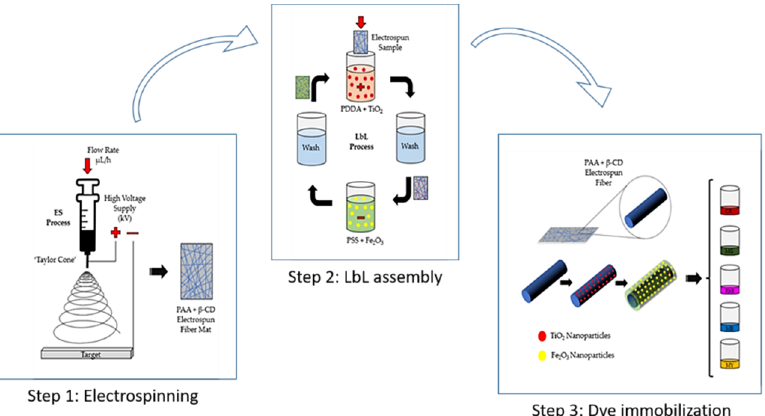
Figure 2. Schematic representation of the three different steps for the fabrication process of the functional coatings by the combination of the electrospinning and LbL assembly techniques.